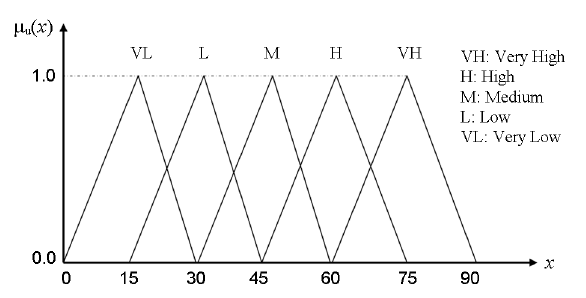
Fig. 2. The hierarchical structure for intelligent building as- sessment